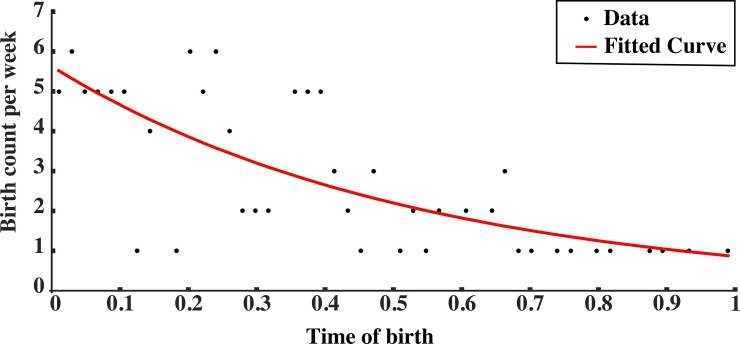
Scatterplot for RAE frequency by week.The black line represents the best fit of the Poisson regression.